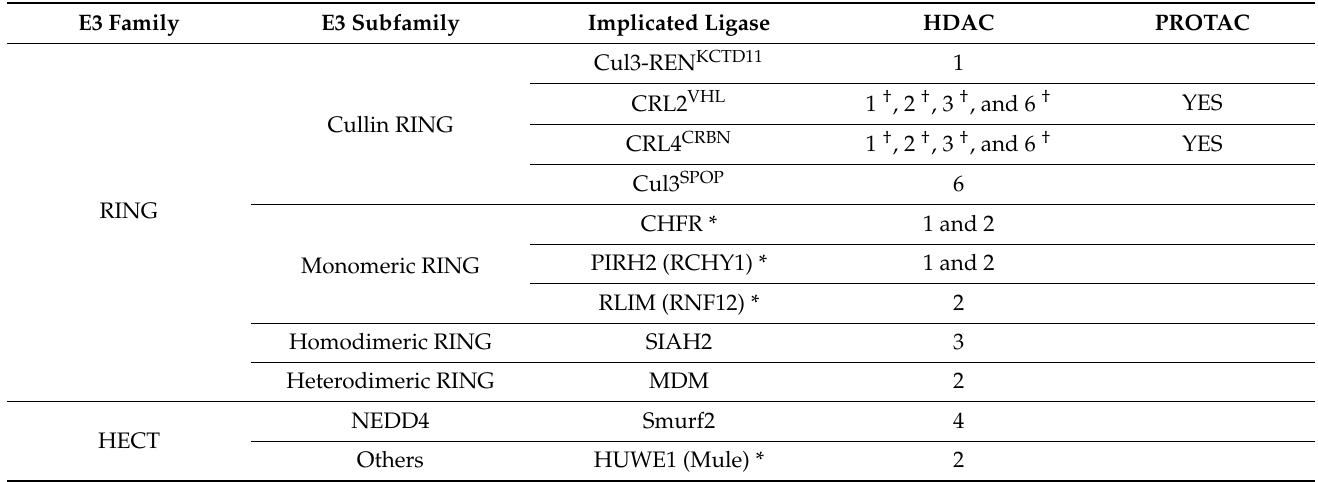
Table 1. List of the E3 ligases implicated in the ubiquitination of the different HDAC isoforms. E3